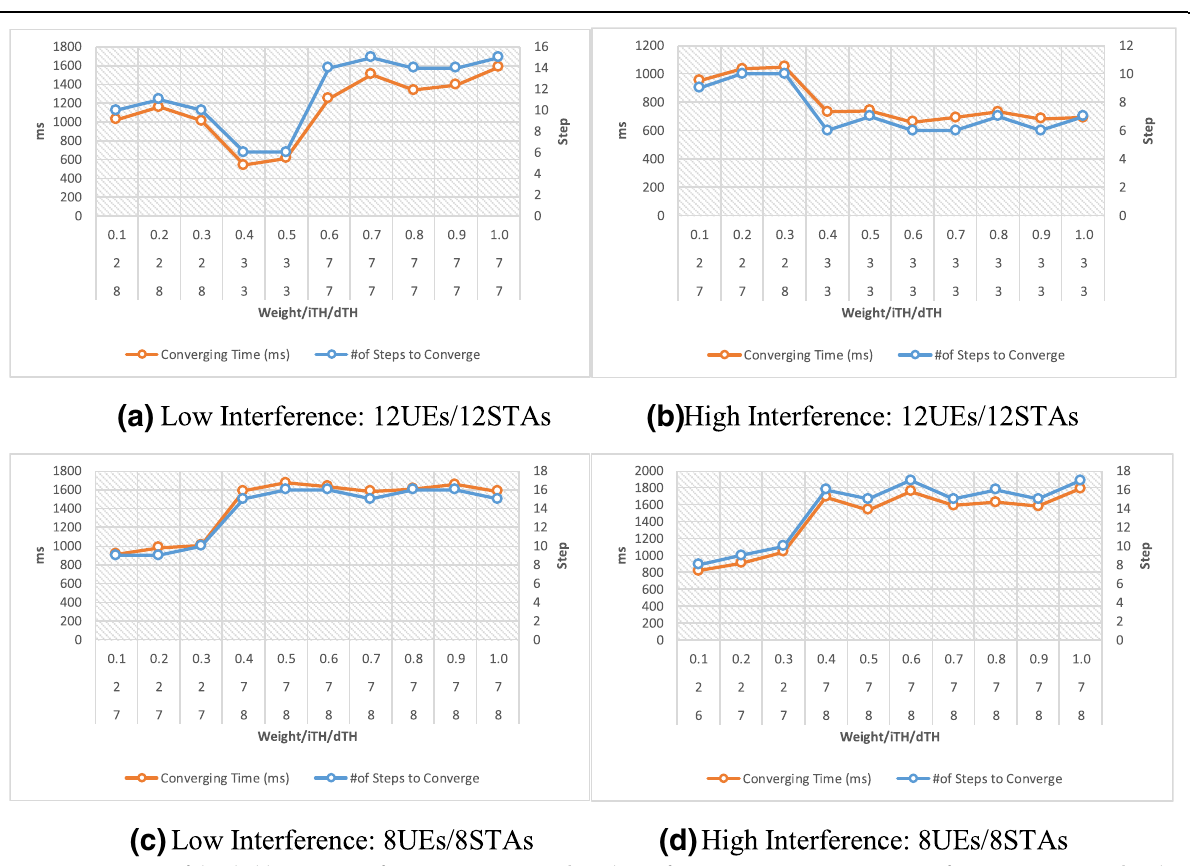
Fig. 7 Convergence of thresholds. a Low interference: 12UEs/12STAs. b High interference: 12UEs/12STAs. c Low interference: 8UEs/8STAs. d High interference: